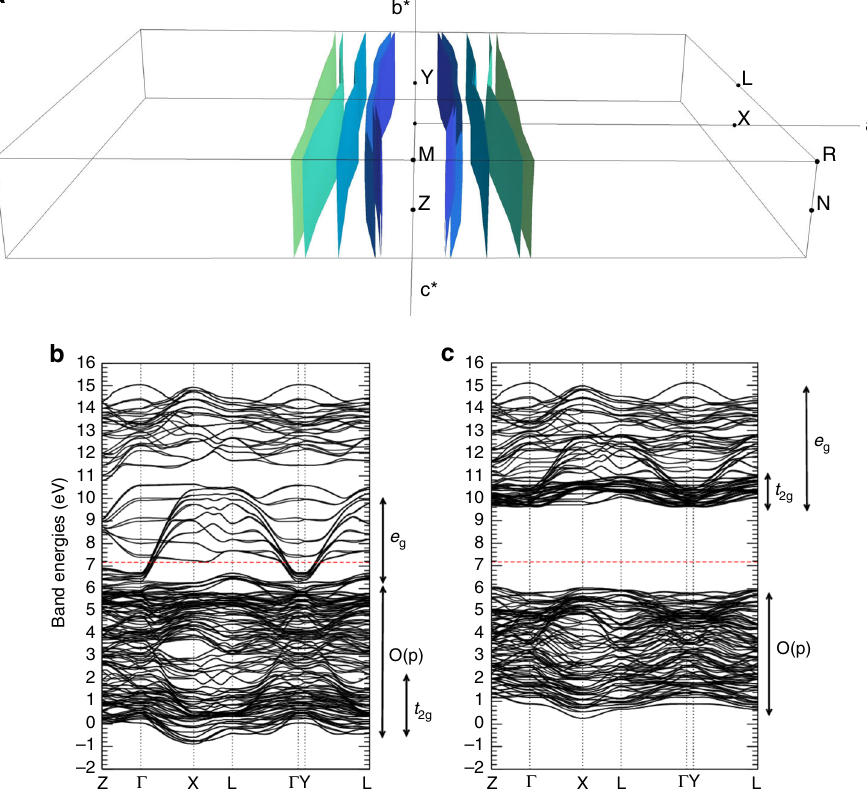
Fig. 3 Main features of the electronic properties of BiMO. a 3D view of the BiMO Fermi surface; b majority and c minority bands of BiMO, calculated with the VPSIC method. Fermi level: horizontal dashed line.